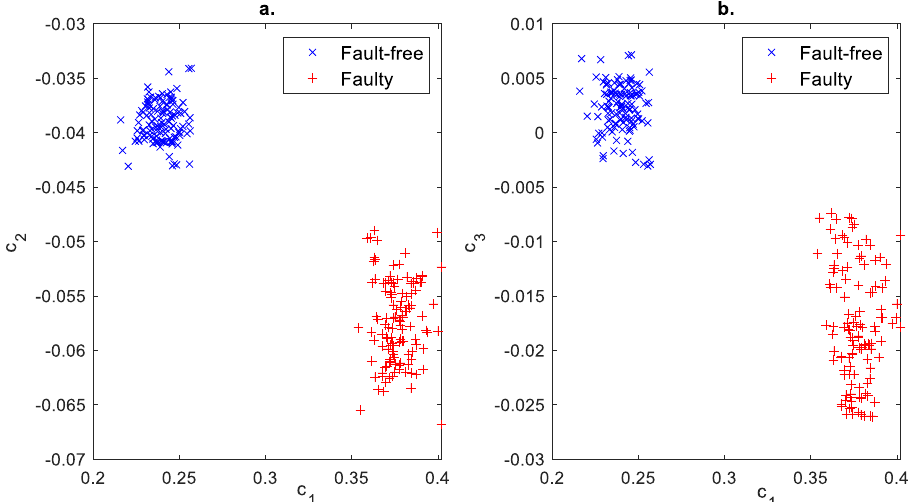
Figure 11. Multifractal spectra for fault-free (blue line) and faulty conditions (red dashed line). The cumulants of the multifractal spectrum were used for damage detection and are presented in Figure 12.